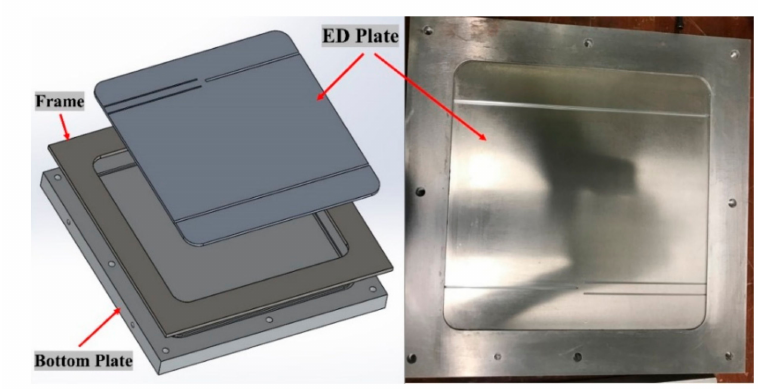
Figure 3. Mold design of the Energy Director (ED) composite laminate manufacturing.